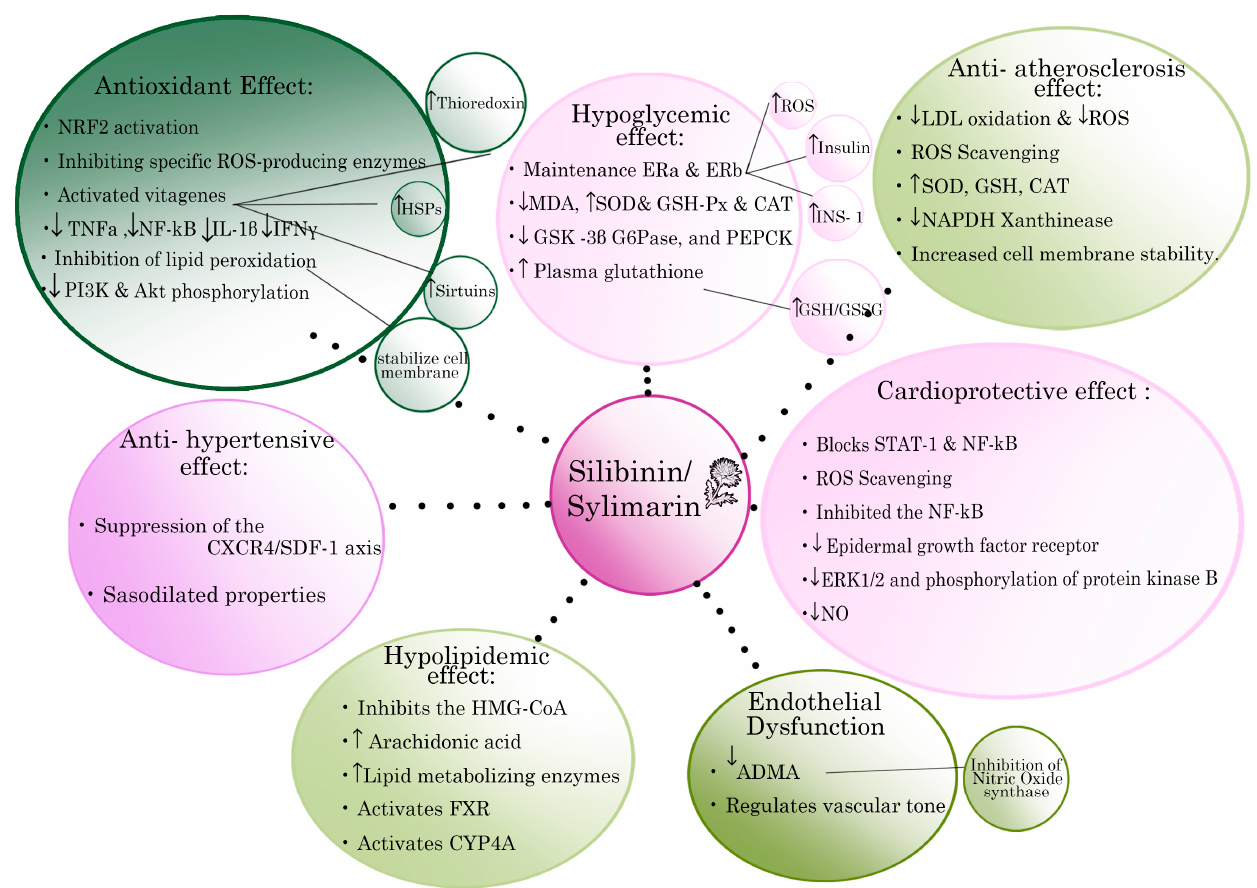
Figure 1. Schematic representation of the most important cardiovascular protective properties of silymarin extract and its main active constituent silibinin and the related possible mechanism of action. Arrows indicate either increase ( ↑ ) or decrease ( ↓ ) of the respective biomarker expression. Key: IL: interleukin; TNFa: Tumour necrosis factor-a; NF- κ B: nuclear factor